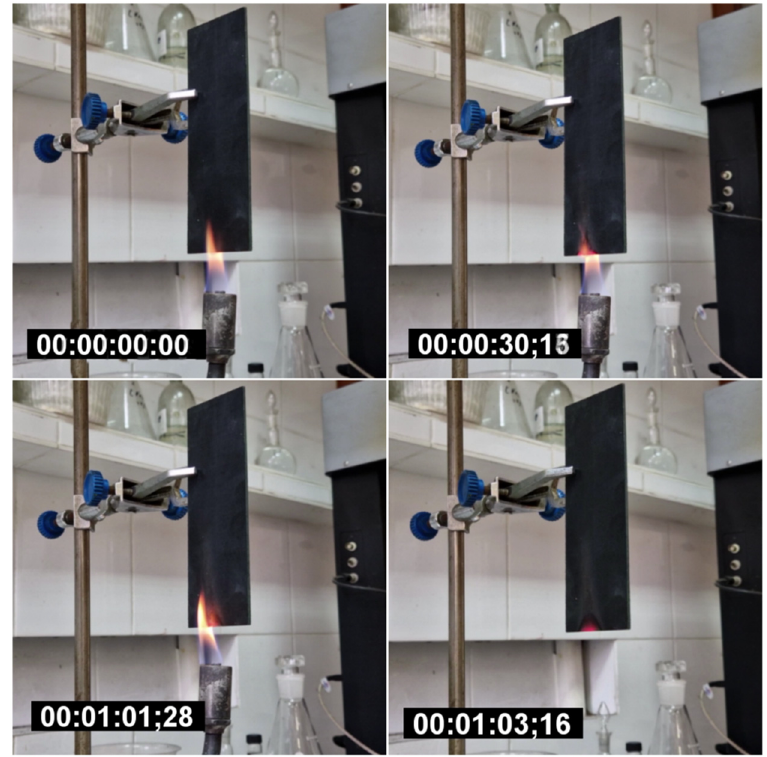
Figure 10. GFRP burning at 900 for 60 s.